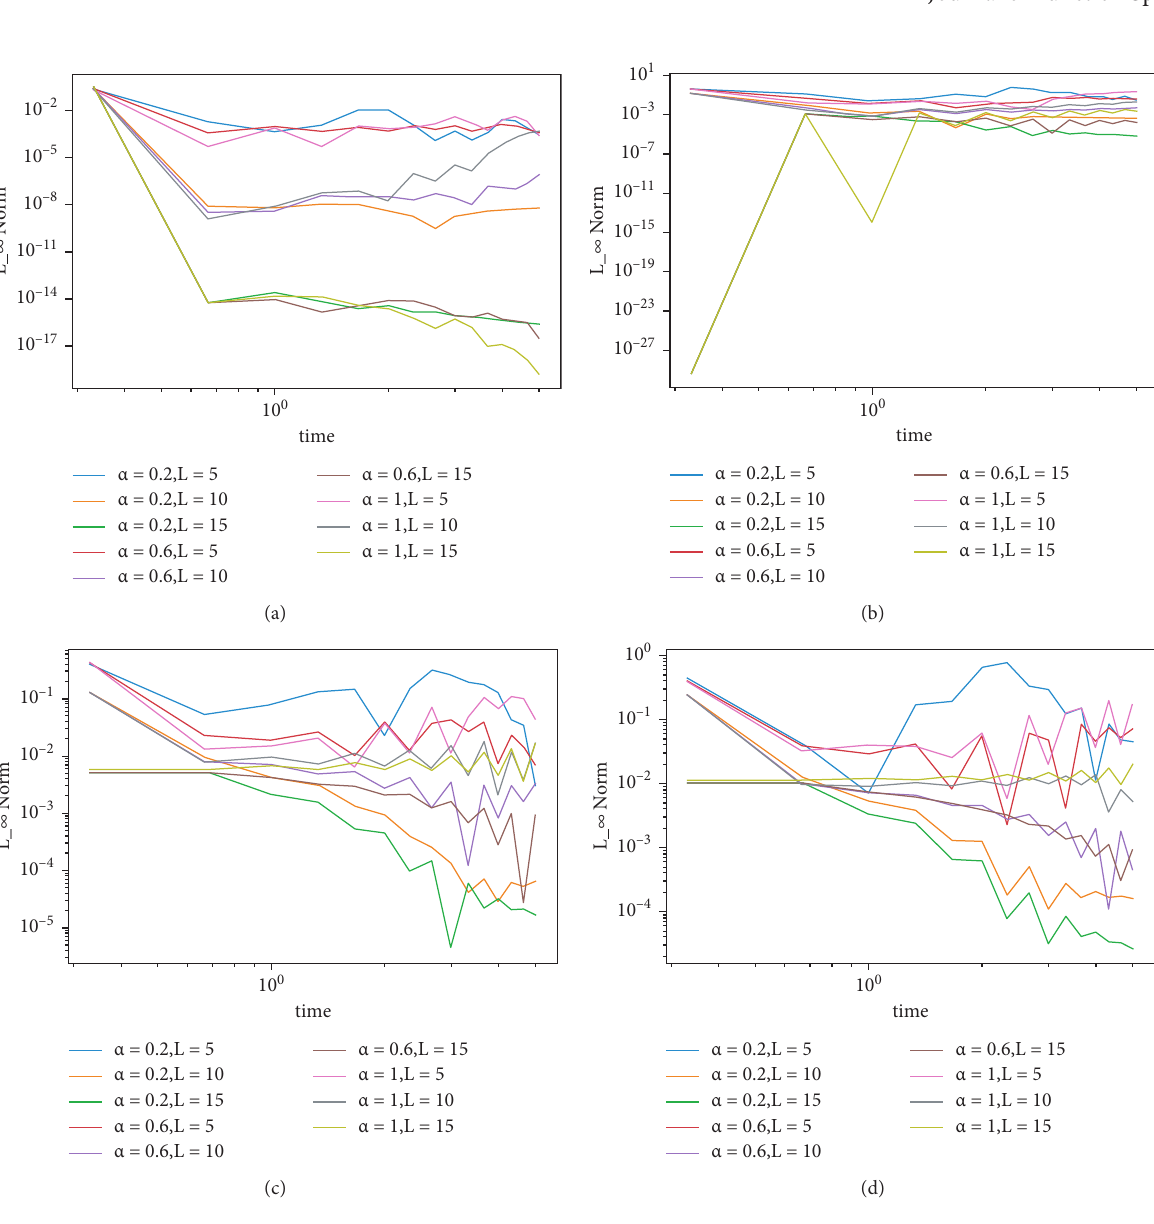
� p � 5 , 10 , 15 , N � 50, M x y